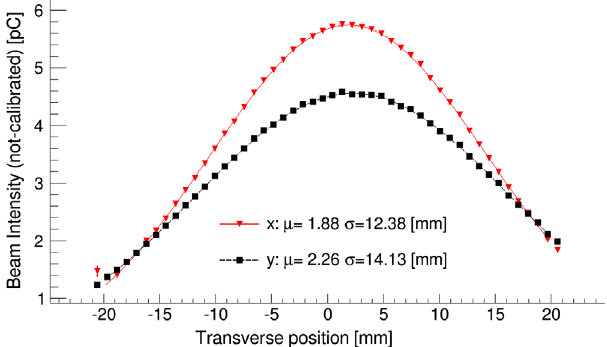
FIG. 25. Raw intensity profile (single pulse average) of the beam freely traveling 160 cm in air and passing through a 16-mm-diameter collimator, 8.5 cm before IC 2